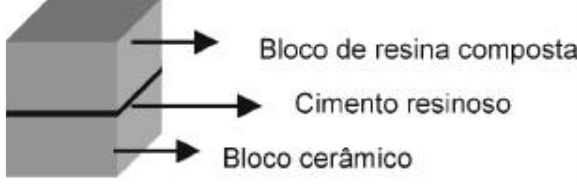
FIGURA 1 - Blocos de resina composta e cerâmica